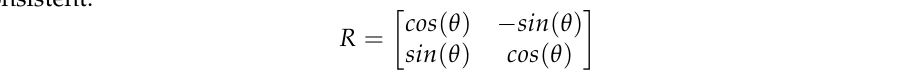
Figure 4. The process of point cloud mapping.